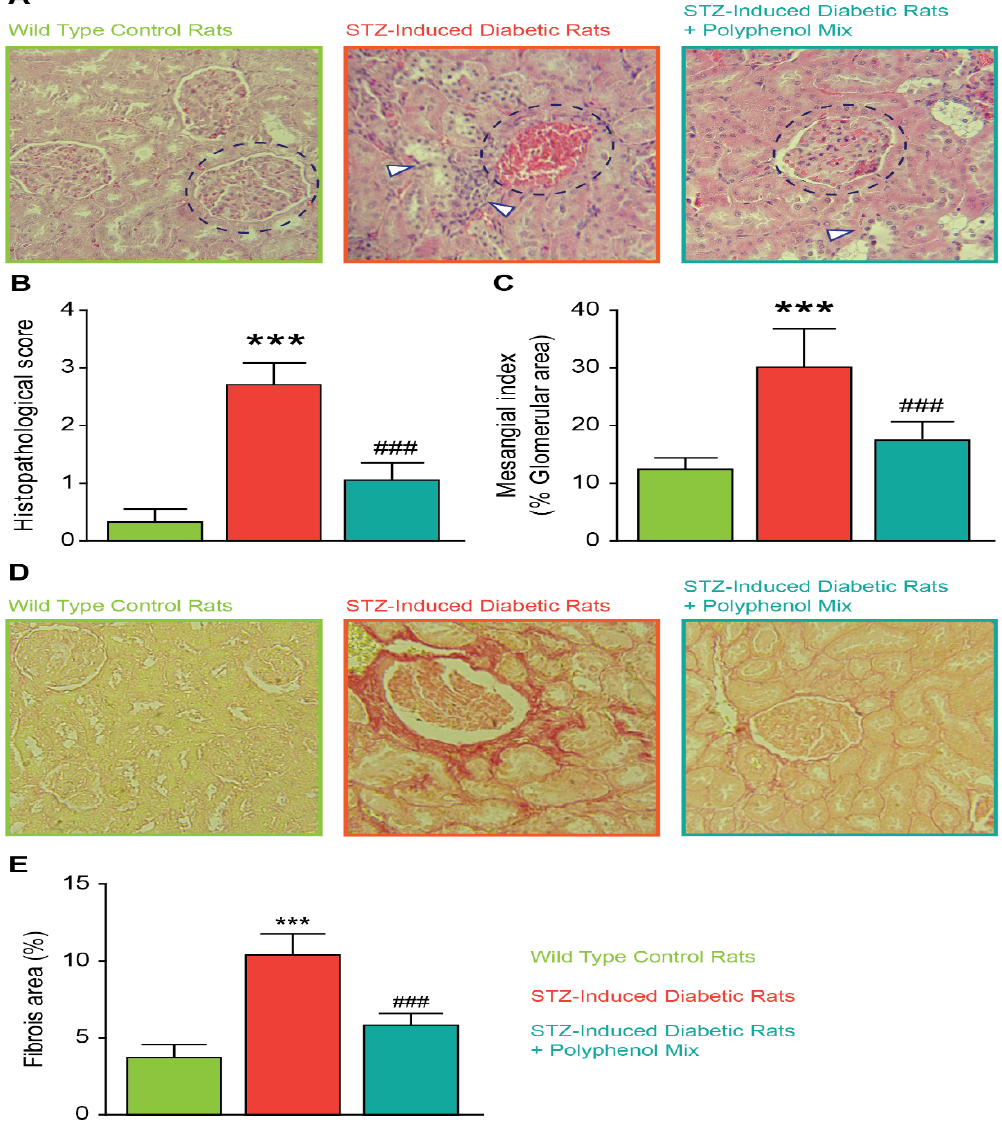
Figure 4. Renal histopathology and quantification. ( A ) Kidney architecture in STZ-induced diabetic rats. Histological examination (H&E stained) (400 × ) in rat kidney of normal group, STZ-induced diabetic group, untreated or treated with the polyphenol mix NCQ. Control kidney section showing normal histological features of glomeruli and tubules (labelled in green). STZ-induced diabetic rat’s kidney showing glomerular degeneration and hypercellularity (labelled in orange). Most of the cortical tubules showed morphologic changes, some of them being tubular necrosis, degeneration of tubular epithelium with interstitial hemorrhage. STZ-induced diabetic rats treated with NCQ (labelled in bleu) showing more remarkable improvement and the glomeruli were normal while renal tubules showed mild necrosis. Bowman’s capsules are highlighted in blue circles in all condition while necrotic cells and tubular epithelium labelled with white arrows. ( B ) Graph showing total histology scores for inflammation and fibrosis in each group. ( C ) The mesangial matrix index